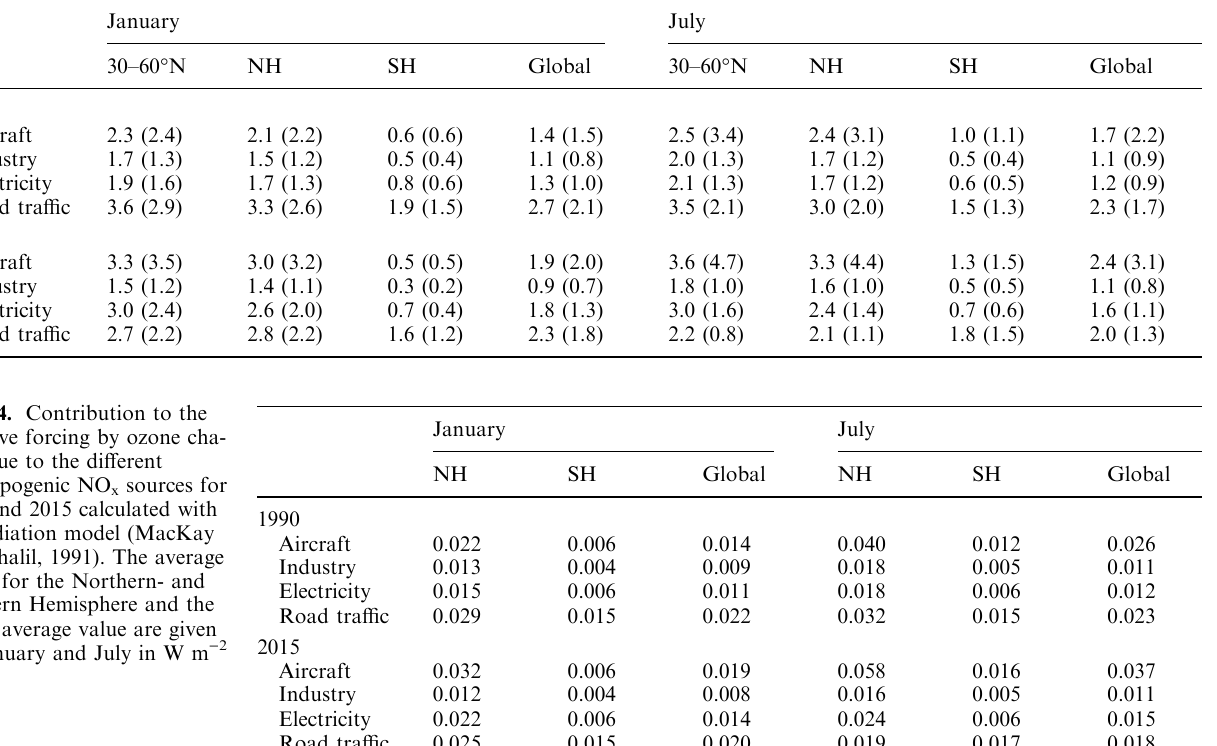
Table 3. Contribution of the anthropogenic NO parentheses). The average percentual changes for 30–60 (cid:176) N, for the Northern- and Southern Hemisphere and the global average are given for